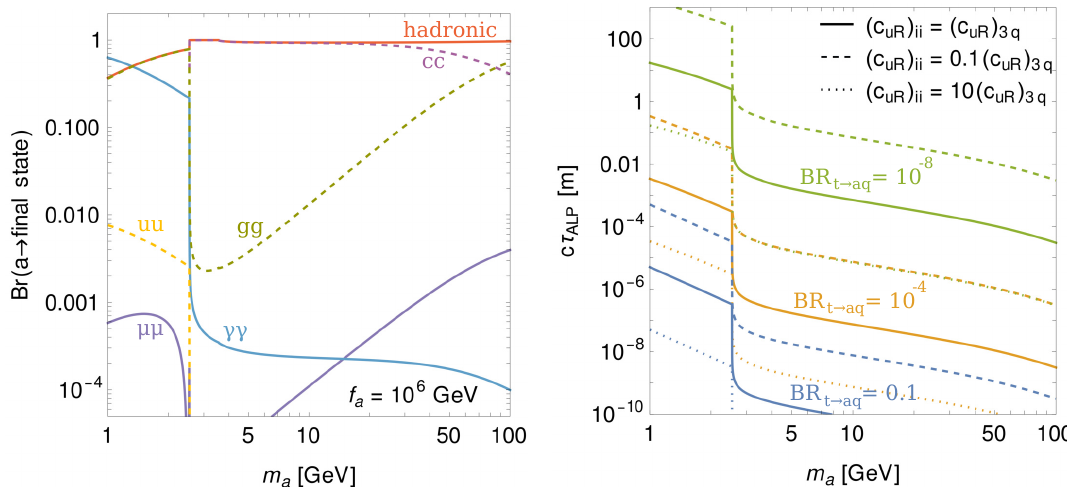
Figure 1 . Left: ALP decay branching ratios as a function of the ALP mass m a for f a = 10 6 GeV. The dashed lines show the contributions to the hadronic channel. Right: lifetime of the ALP as a function of the ALP mass. The blue, orange and green lines show Br( t → aq ) = 10 − 1 , 10 − 4 and 10 − 8 , respectively. Solid, dashed and dotted lines refer to ( c u